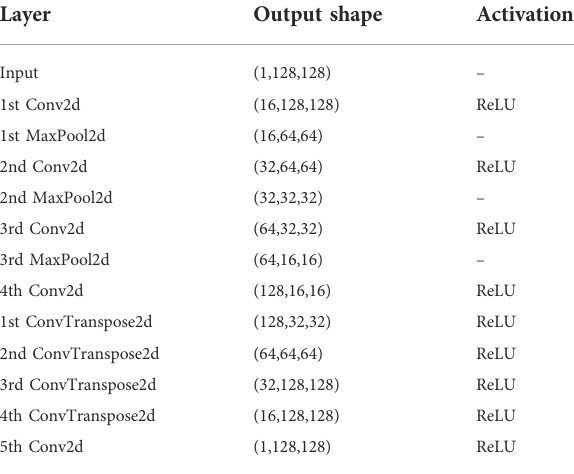
TABLE 1 Network structure of the CookieNetAE